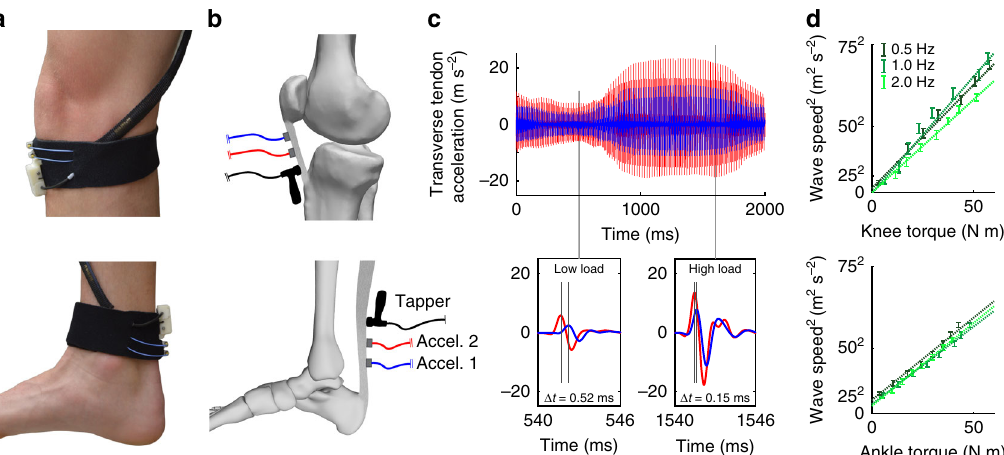
Fig. 3 In vivo wave speed measurements. a Shear wave tensiometers secured over the patellar and Achilles tendons. b The tensiometers consisted of a piezo-actuated tapper and two miniature accelerometers spaced a fi xed distance apart. c Representative recording of patellar tendon transverse accelerations demonstrate that the travel time ( Δ t ) between accelerometers is shorter in the high load condition, re fl ecting faster wave propagation. d Linear relationships between joint torque and squared wave speed (binned means ± 1 s.d. for a representative subject) were observed in both tendons across a range of loading